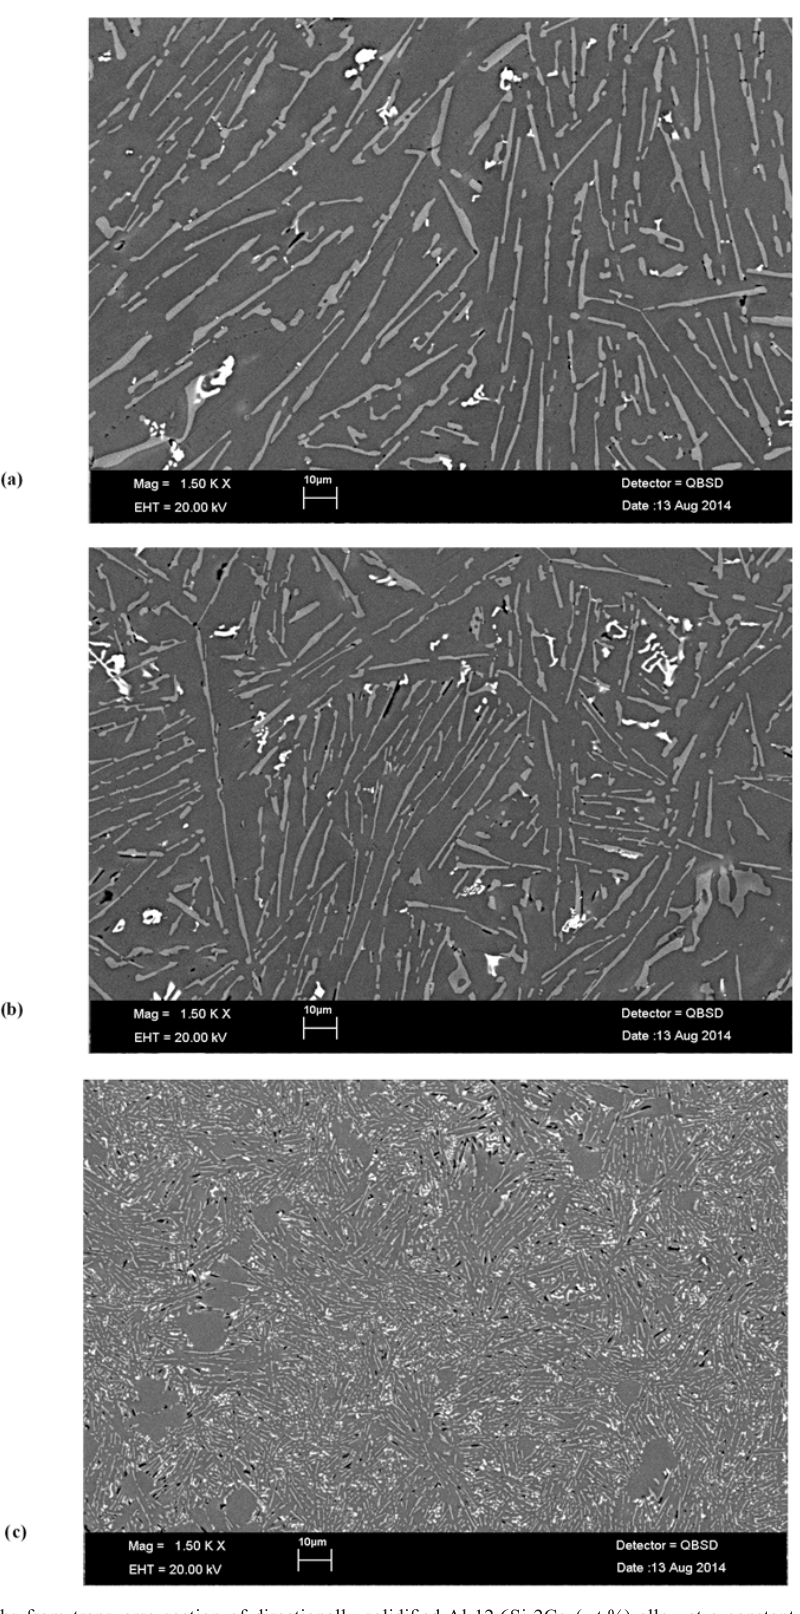
Fig. 2 Micrographs from transverse section of directionally solidified Al-12.6Si-2Co (wt.%) alloy at a constant G (7.60 K/mm): (a) V = 8.35 μm/s), (b) V = 41.63 μm/s), (c) V = 166.30